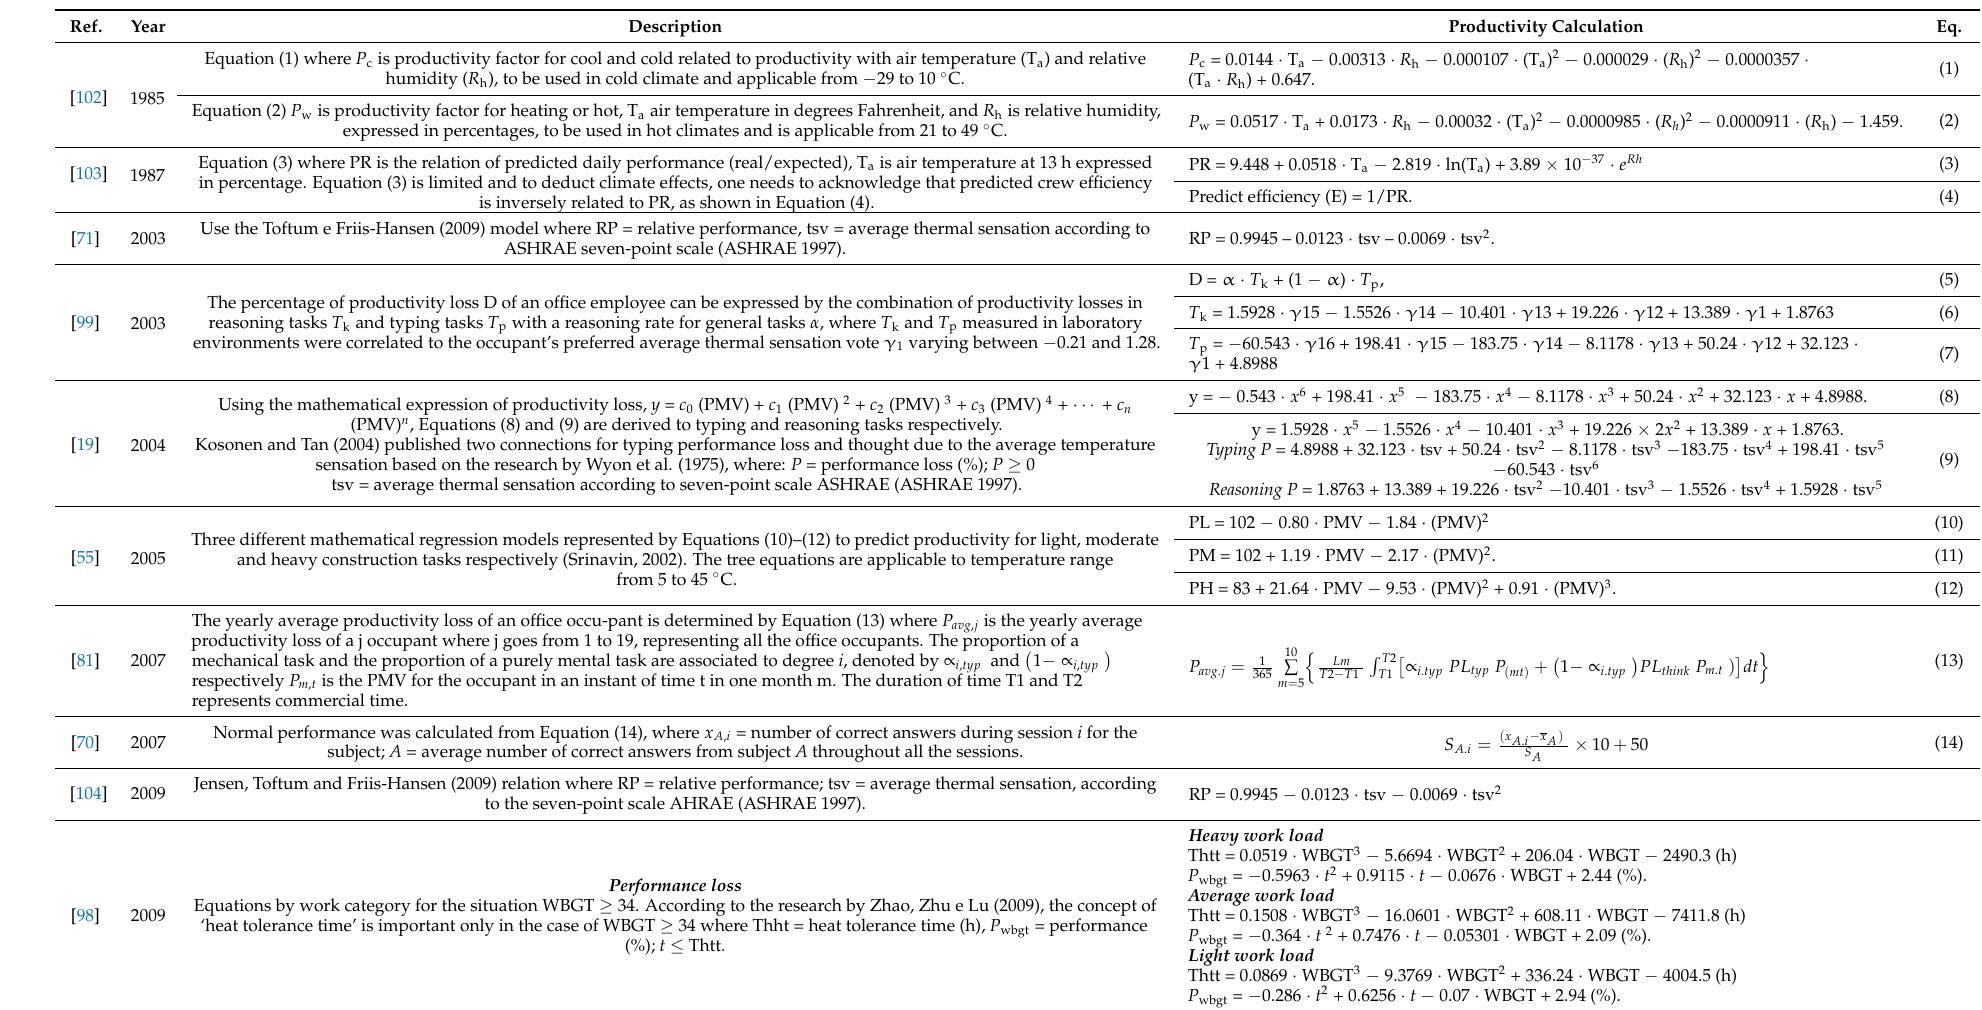
Table 6. Performance/productivity